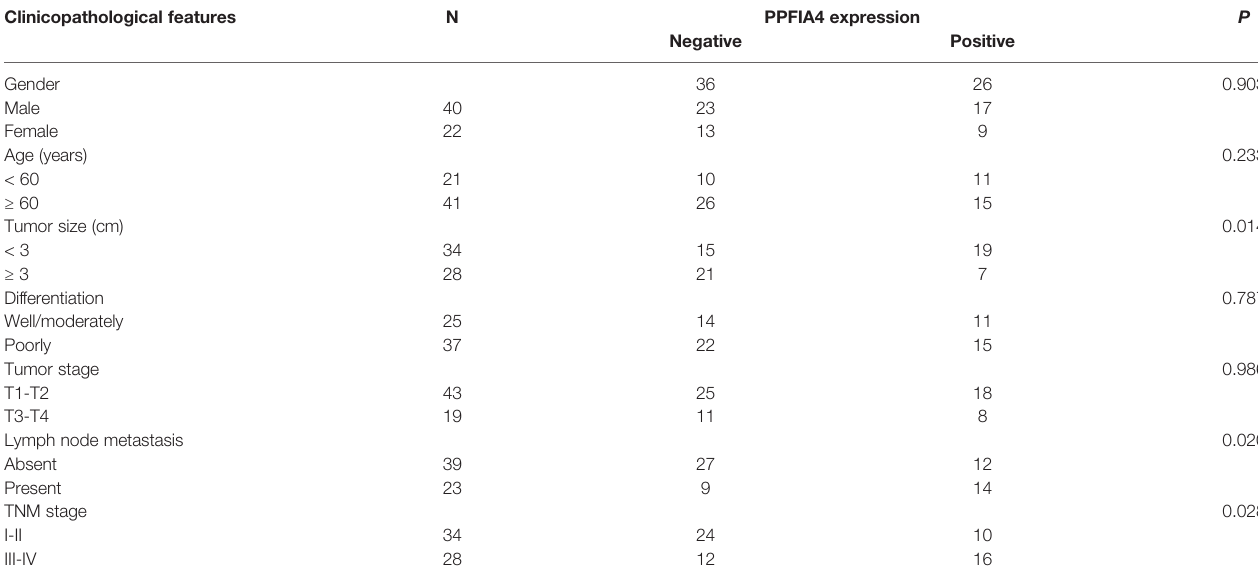
TABLE 1 | Relationships between PPFIA4 expression and clinicopathological